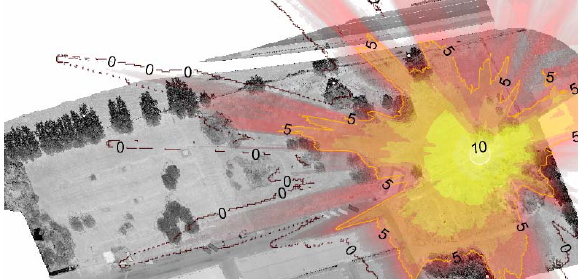
Figure 12. Estimated contamination map, radiation levels based on source location and constructed ground model are shown in log scale and color-coded, scenario A.